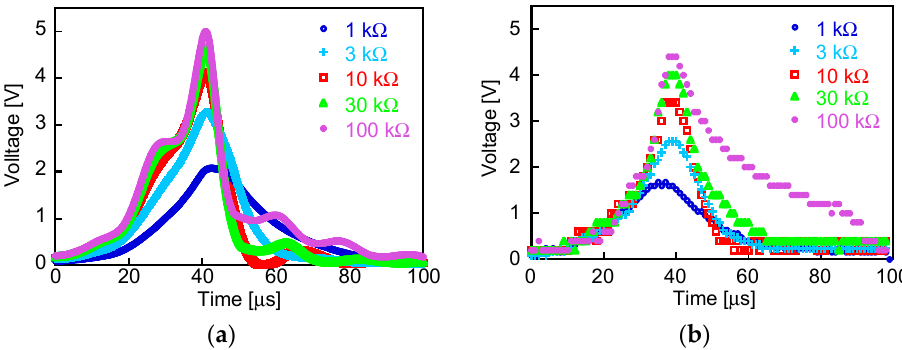
Figure 9. Waveforms of ( a ) experimentally measured and ( b ) calculated output voltage, V out , across the load resistor. Load resistance R = 1, 3, 10, 30, and 100 k Ω .